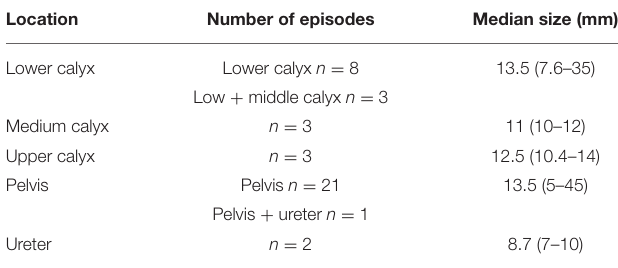
TABLE 1 | Clinical characteristics. TABLE 2 | Lithiasis episodes classification according to its location and number.